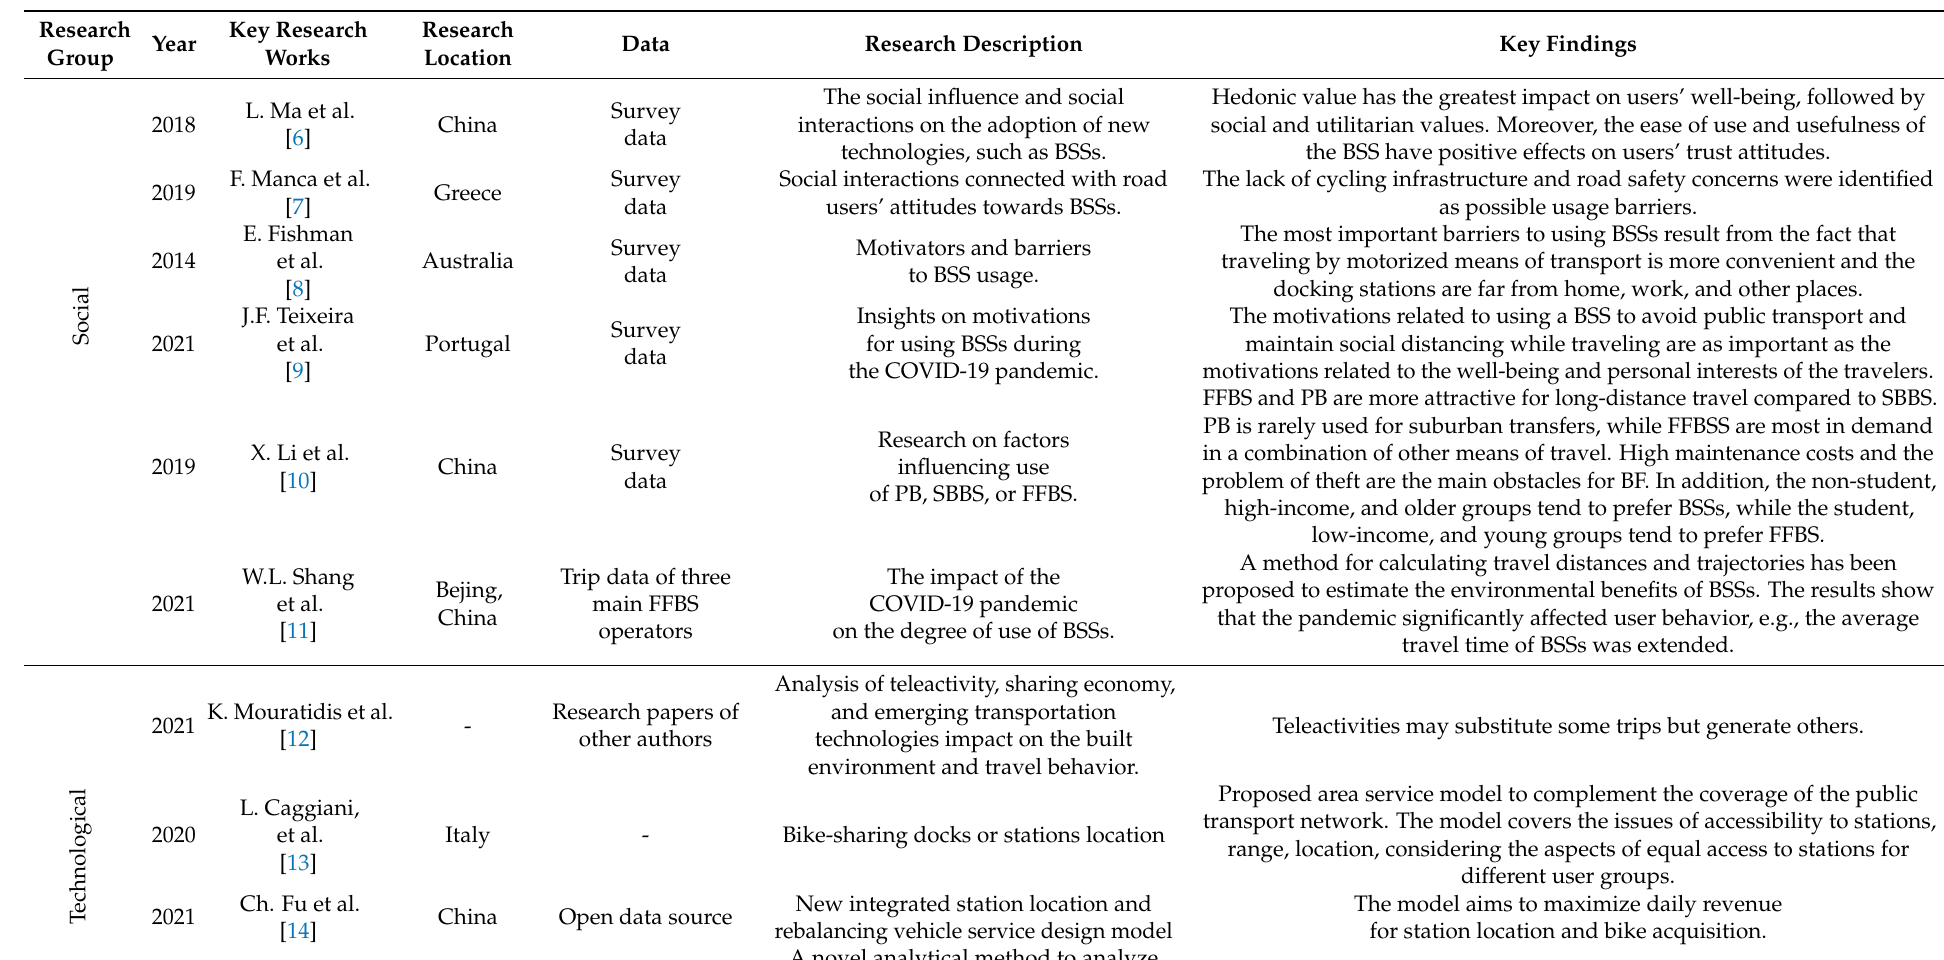
Table 1. The summary of the most important directions of research work dedicated to the development of